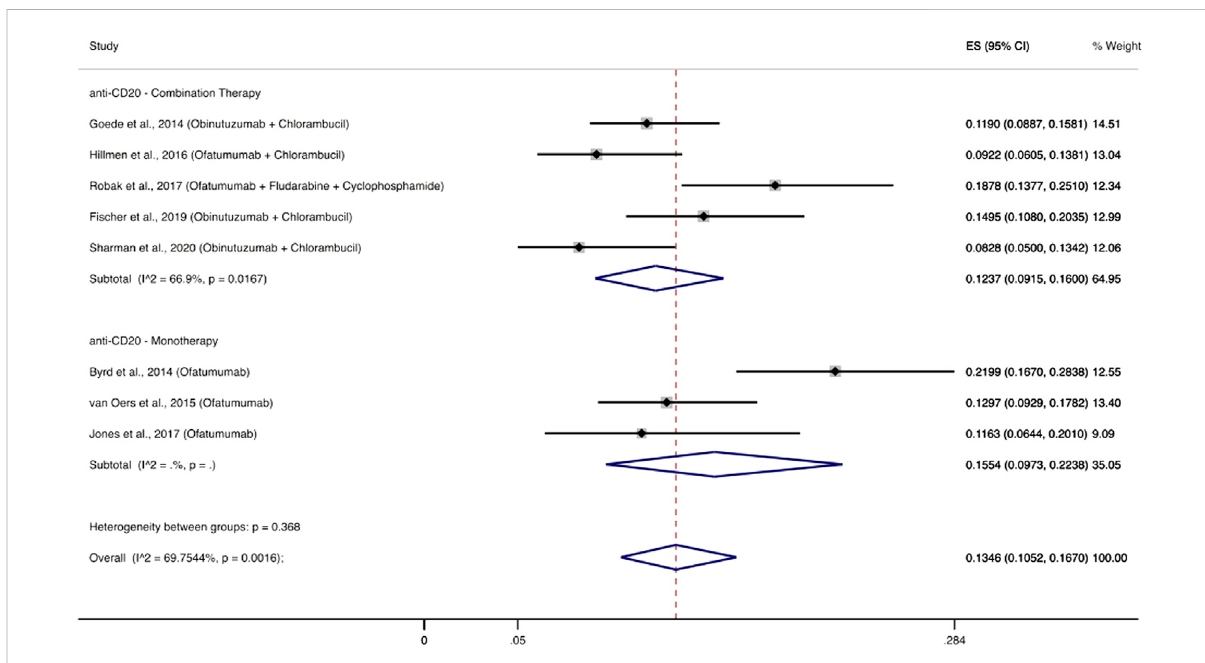
FIGURE 5 Cumulativeincidencerateofsevereinfectionsfor secondgenerationanti-CD20 monoclonalantibodies.Individual and combinedestimatesof the incidence of severe infections for patients treated with second generation anti-CD20 monoclonal antibodies with 95% con fi dence intervals. ES: Effect Size (Cumulative